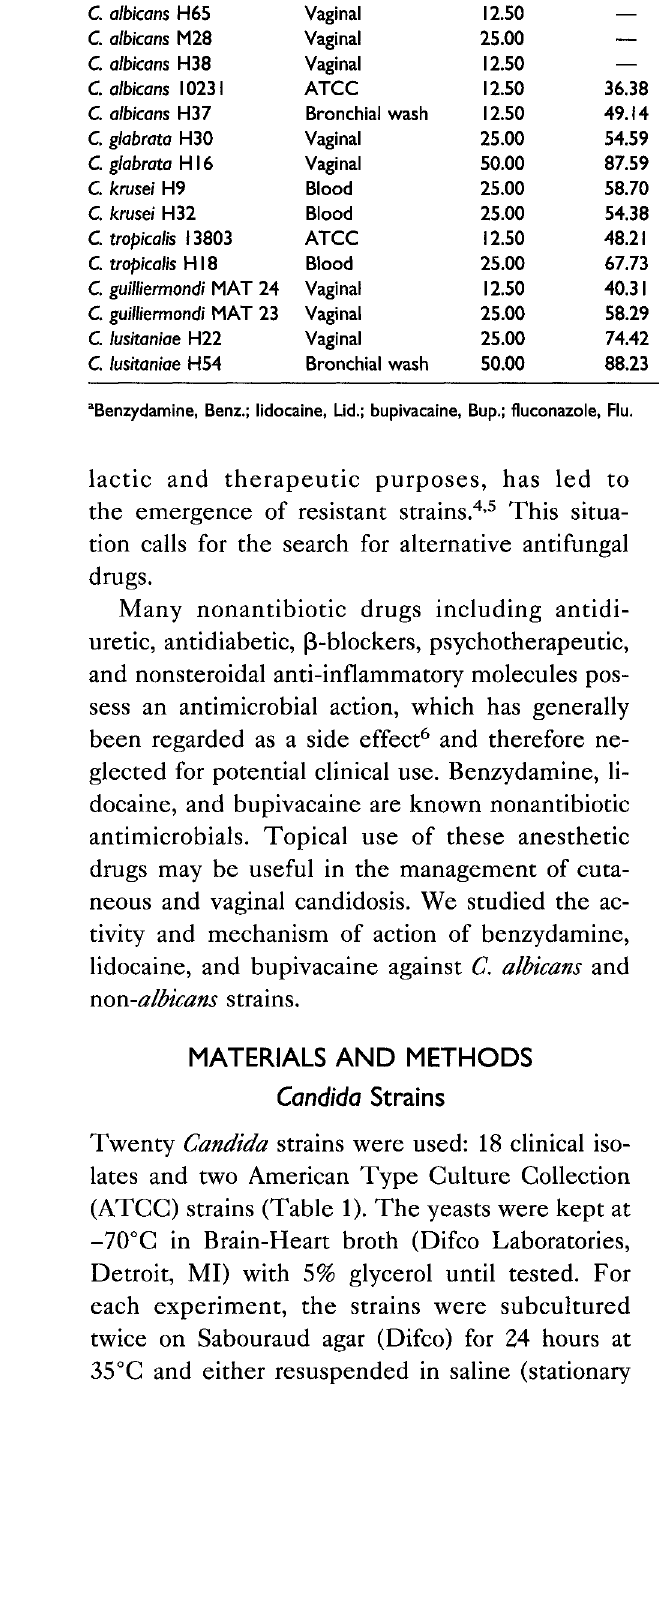
MIC Benz. LCso Benz. MIC Lid. LCso Lid. MIC Bup. LCso Bup. MIC Flu.